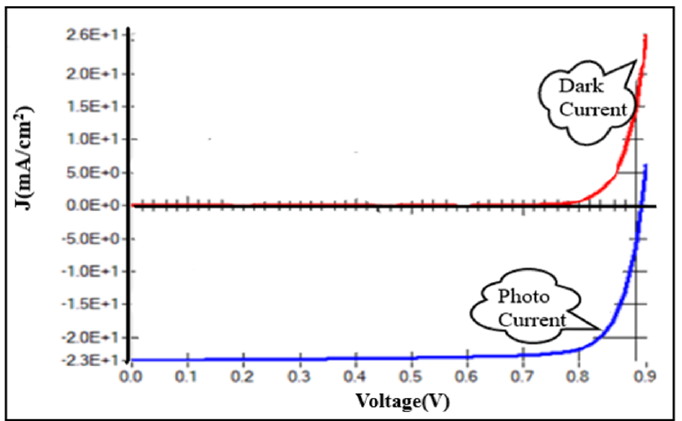
Figure 9. Current density with voltage, at T = 300 K, (CdTe N A = 2 × 10 15 cm − 3 , ZnSe N D = 1 × 10 22 cm − 3 and SnO 2 N D = 1 × 10 22 cm − 3 ).